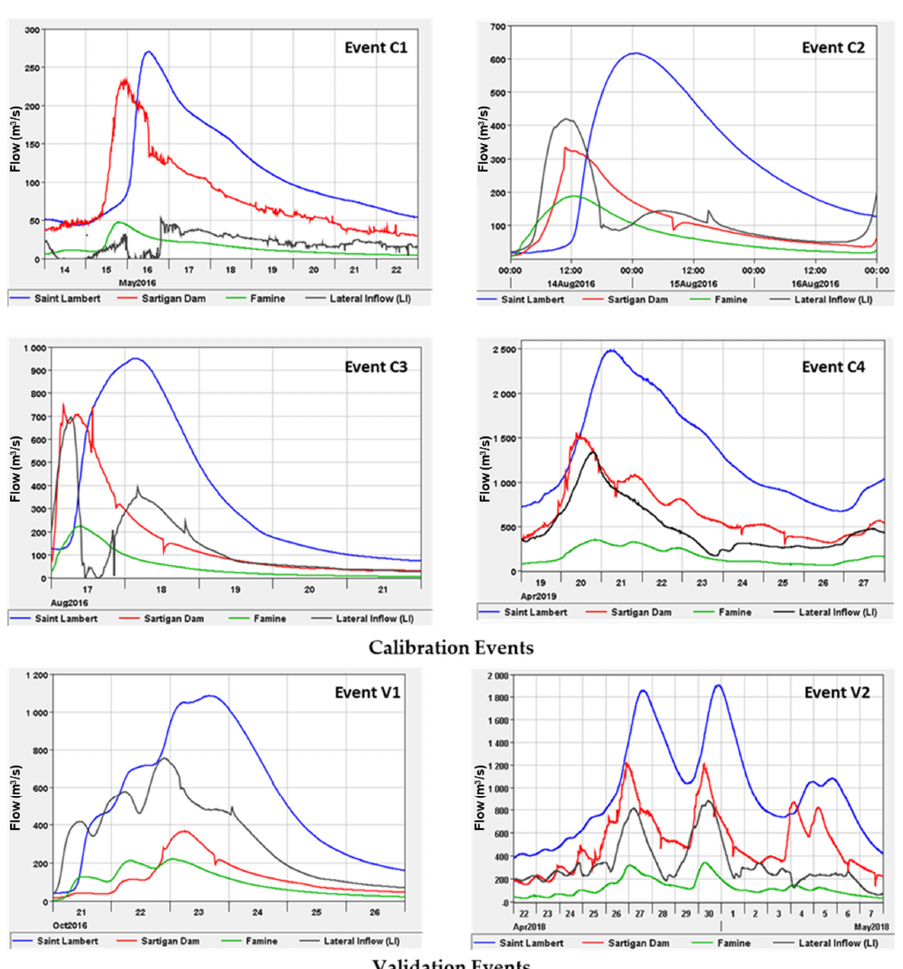
Figure 5. Calibration and validation hydrographs. Locations are schematically drawn in Figure 2.